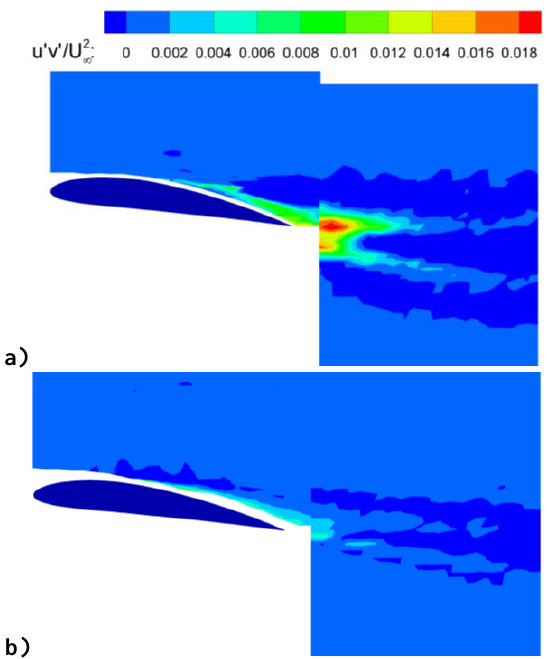
Fig. 7. Reynolds Stress results for Re=5x10 4 , α=8º and z/s=0.4 a) uncontrolled case, b) partially flexible airfoil.